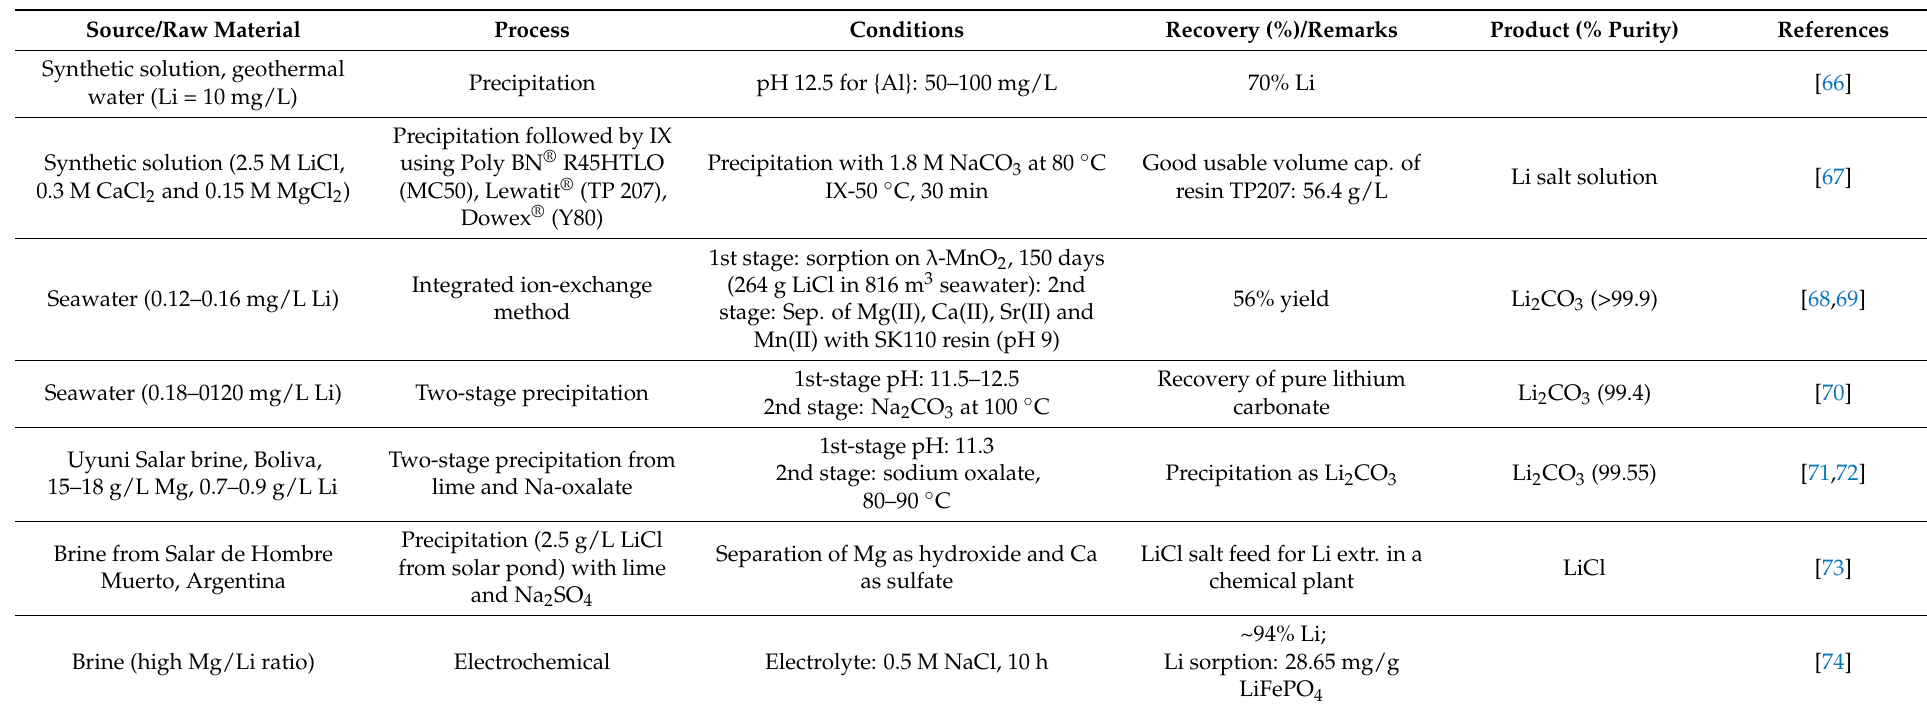
Table 5. Precipitation methods for extraction of lithium